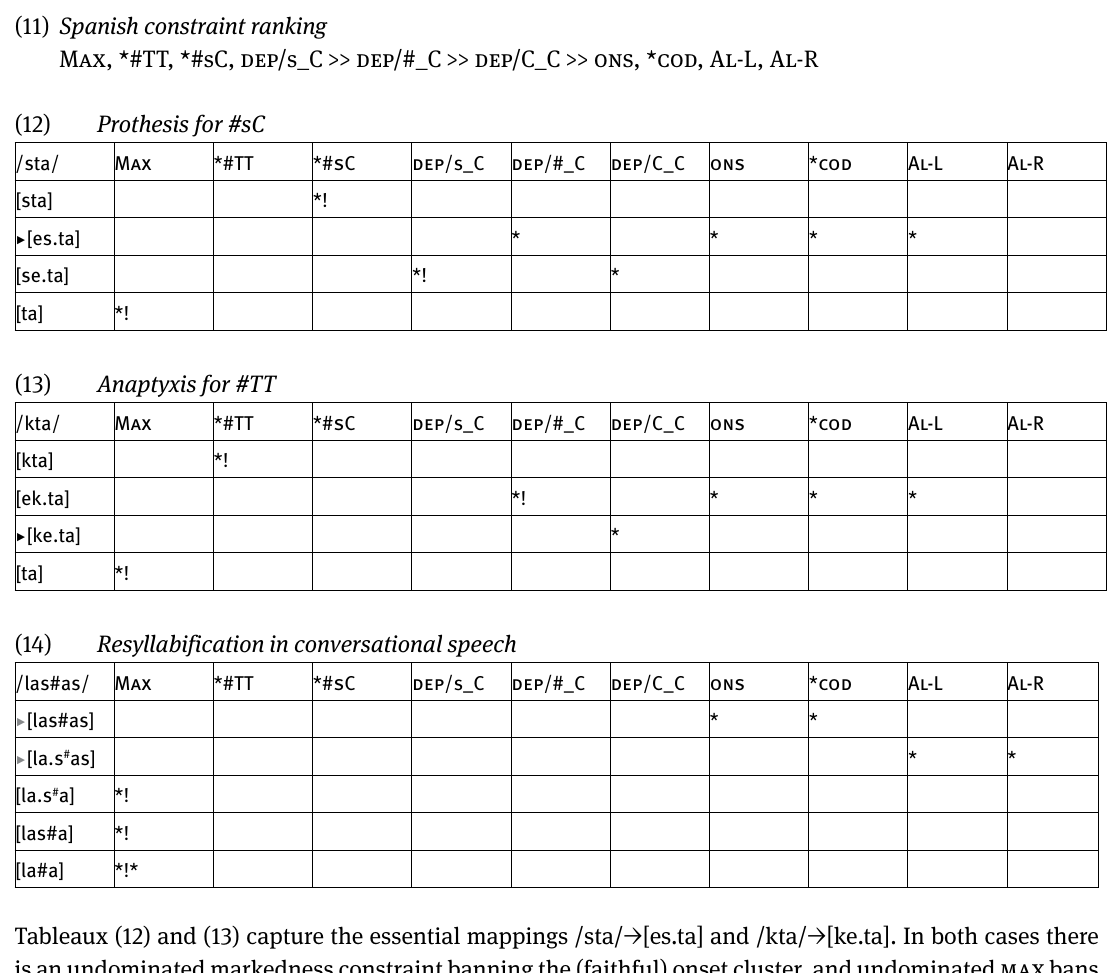
Tableaux (12) and (13) capture the essential mappings /sta/→[es.ta] and /kta/→[ke.ta]. In both cases there is an undominated markedness constraint banning the (faithful) onset cluster, and undominated max bans deletion. The ranking dep/s_C >> dep/#_C ensures that prothesis is preferred to anaptyxis for sC , while the ranking dep/#_C >> dep/C_C yields the opposite preference for other illicit clusters. The remaining constraints (other than Al-R) must be inactive in (12, 13), since all of them are violated by the winning prothetic candidate in (12). Finally, the native conversational resyllabification process is illustrated in (14), where both options incur violations of bottom-ranked syllable well-formedness or prosody/morphology alignment constraints. We indicate that variation is possible in this case by using multiple, gray ‣ symbols rather than a single black ‣ symbol. Note that classical OT does not provide a formal mechanism to encode the rate-of-speech effect, whereby faithfulness gives way to markedness at faster rates of speech and/or more informal speech registers. Thus, in (14) we simply indicate that variation is possible and assign all relevant constraints to the same bottom